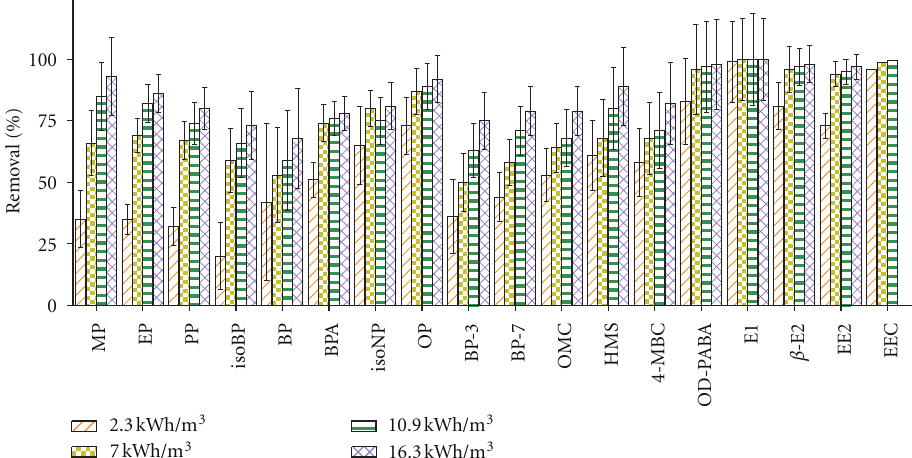
Figure 4: The removal of estrogenic compounds from wastewater e ffl uent by photolysis. The error bars present the 95% confidence interval. The abbreviation can be found in Table 1.